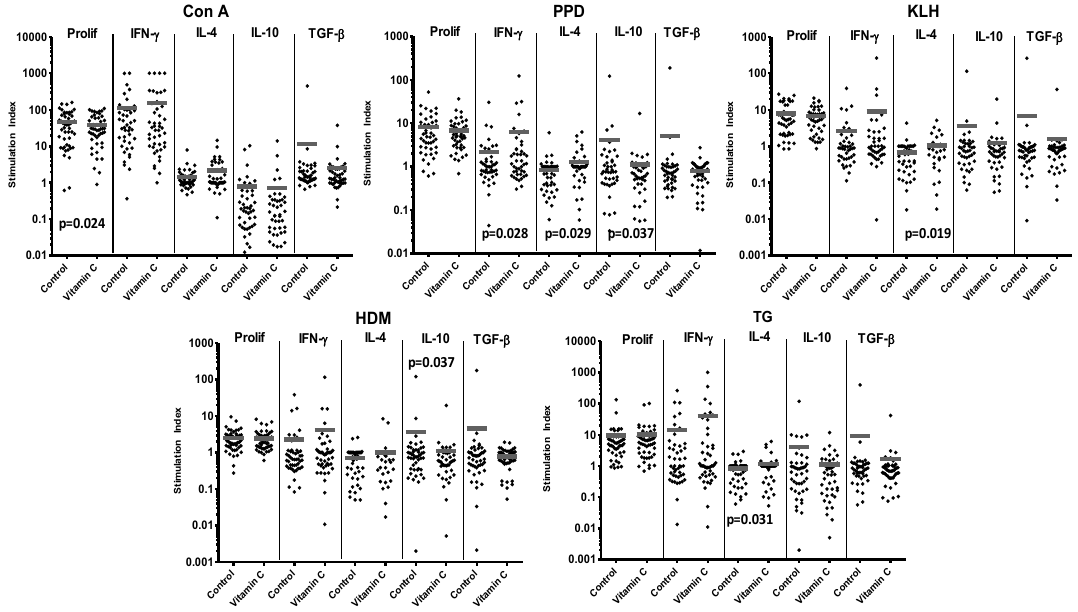
Figure 3. Responses of 51 CBMC samples to control stimuli and allergens, with or without supplementation with vitamin C. Reponses are expressed as stimulation index. Bars represent mean stimulation indices for each set of culture conditions. Significant p values for differences in responses between paired samples in cultures with or without vitamin C supplementation are shown on the relevant